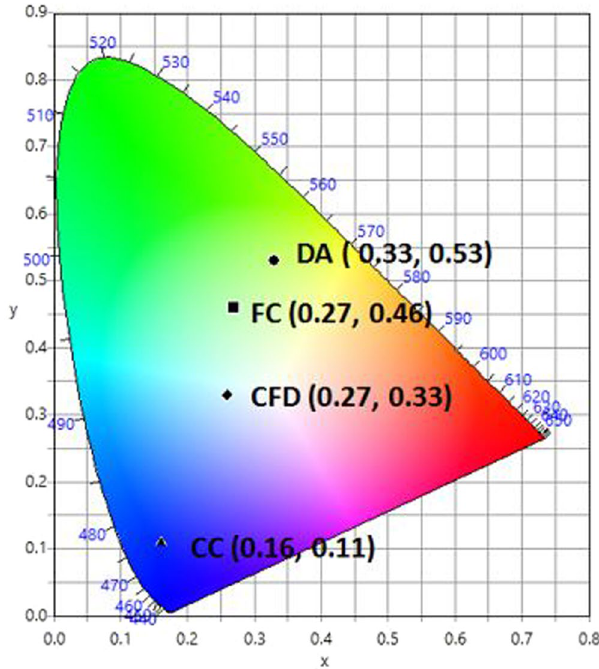
Figure 4. CIE-1931 diagram. Chromaticity plot for colour coordinates of CC ( ▲ ), FC ( ■ ), DA ( ● ) and for the mixture, CFD (◆) corresponding to a ratio of 1.375:1:7 CC:FC:DA, in ethanol solution.